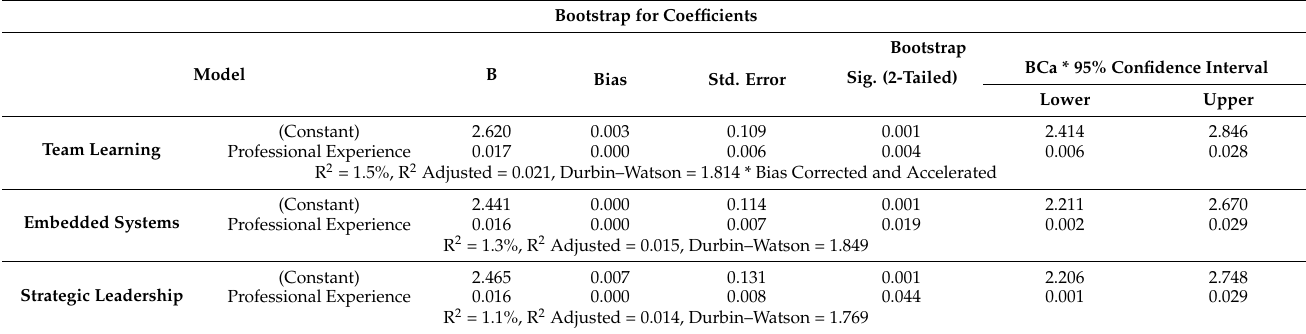
Table 10. Summary Statistics of regression coefficients for bootstrap regression based on observations (B =